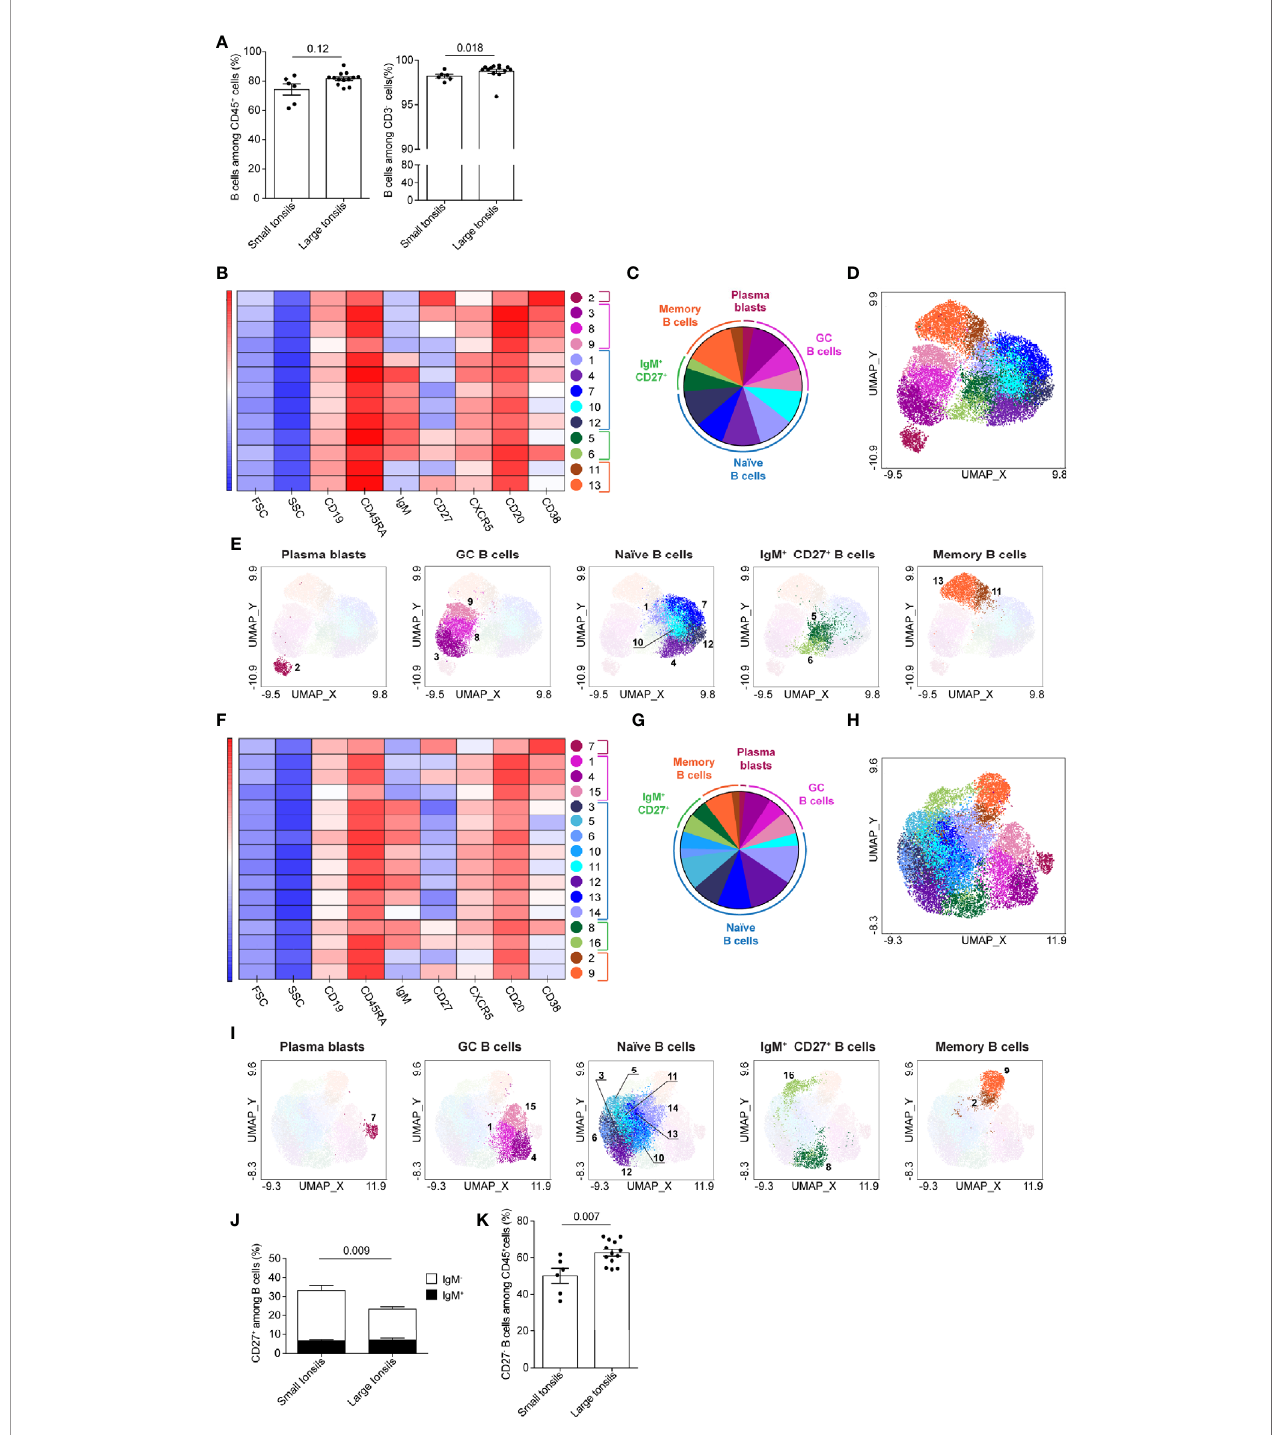
FIGURE 4 | B-cell clusters in tonsils of pediatric patients with OSA. (A) Frequency of B cells among total living CD45 + cells and CD3 - cells. (B – I) B-cell clusters in small (B – E) and large (F – I) tonsils from patients with OSA, identi fi ed by PhenoGraph in the concatenated fi les. (B, F) Heatmap of marker expression intensity scaled individually for each marker. (C, G) Diagram showing proportions of PhenoGraph clusters and combined functional groups. (D, E, H, I) PhenoGraph clusters overlaid on the corresponding UMAP together (D, H) or separated by functional group (E, I) . (J) Frequency of CD27 + cells among total B cells; black bars indicate IgM + and white bars indicate IgM - subsets. (K) Frequency of CD27 - B cells among total living CD45 + cells (A, J, K) Bars and error bars indicate mean ± SEM. Statistical signi fi cance was calculated using Mann-Whitney U